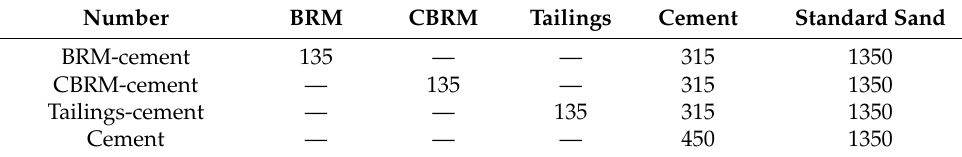
Table 3. Design of different cement mortars